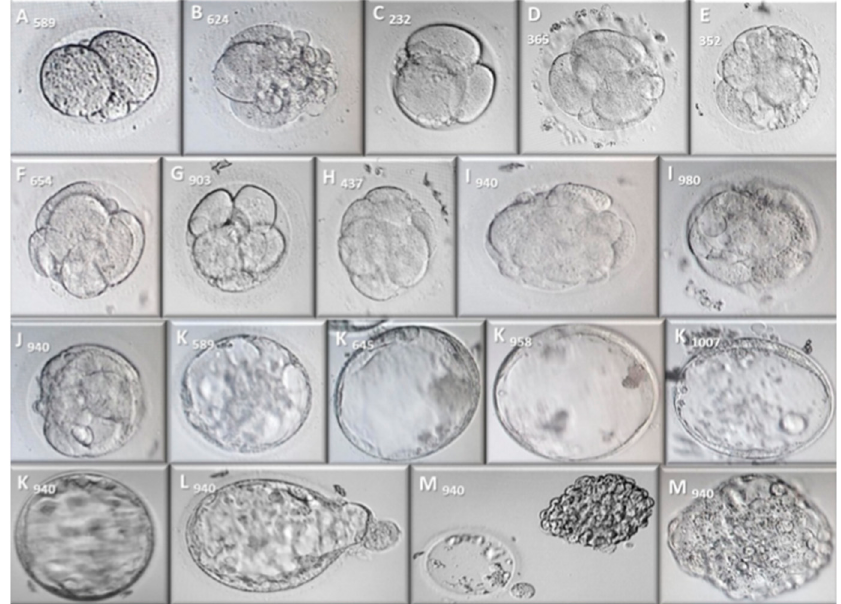
Figure 2. Bright field micrographs of embryos after activation. micrographs are labeled with a letter and a number. The letter refers to the stage of embryonic development and the number to the oocyte PI of the study. ( A ) 2-cell embryo. ( B ) 3-cell embryo. ( C ) 4-cell embryo. ( D ) 5-cell embryo. ( E ) 6-cell embryo. ( F ) 7-cell embryo. ( G ) 9-cell embryo. ( H ) Early compaction. ( I ) Morula. ( J ) Formation of the blastocyst cavity. ( K ) Fully expanded blastocyst. ( L ) Hatching blastocyst. ( M ) Hatched blastocyst. All micrographs were taken 20×, except the first image “M940” with a 10× objective.